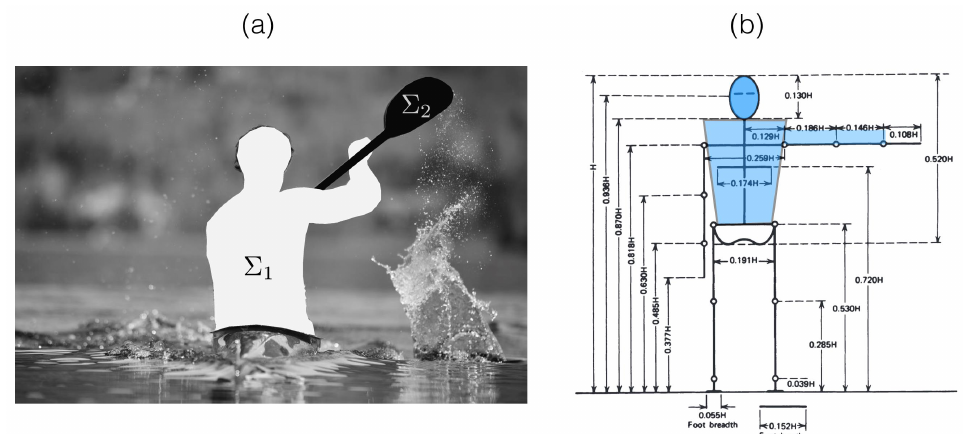
Figure A2. ( a ) Identification of the two bluff-emerged surfaces gma 1 for the kayaker and gma 2 for the unshadowed part of the paddle. ( b ) Anthropometric figure with data extracted from the work by Drillis and Contini;